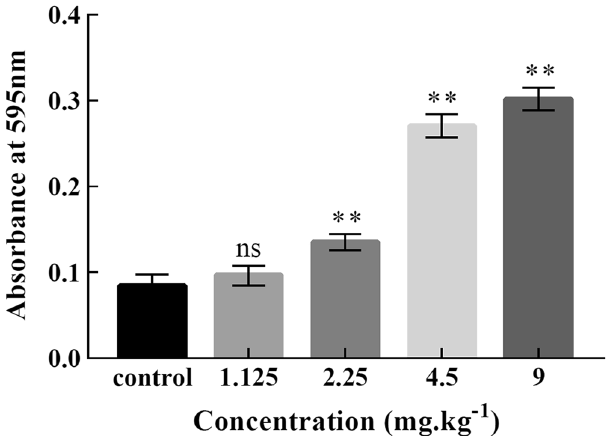
Figure 2. ROS in Drosophila larvae increased under higher concentration of cadmium stress. Nitroblue tetrazolium reduction assay for the estimation of reactive oxygen species (ROS) in Drosophila larvae exposed to Cd (Mean ± SD, n = 3, 50 larvae per sample, ** P < 0.01, ns = not significant). The absorbance values of treatment groups of 2.25 mg/kg, 4.5 mg/kg and 9 mg/kg have extremely significant differences compared with the control group ( P < 0.01).